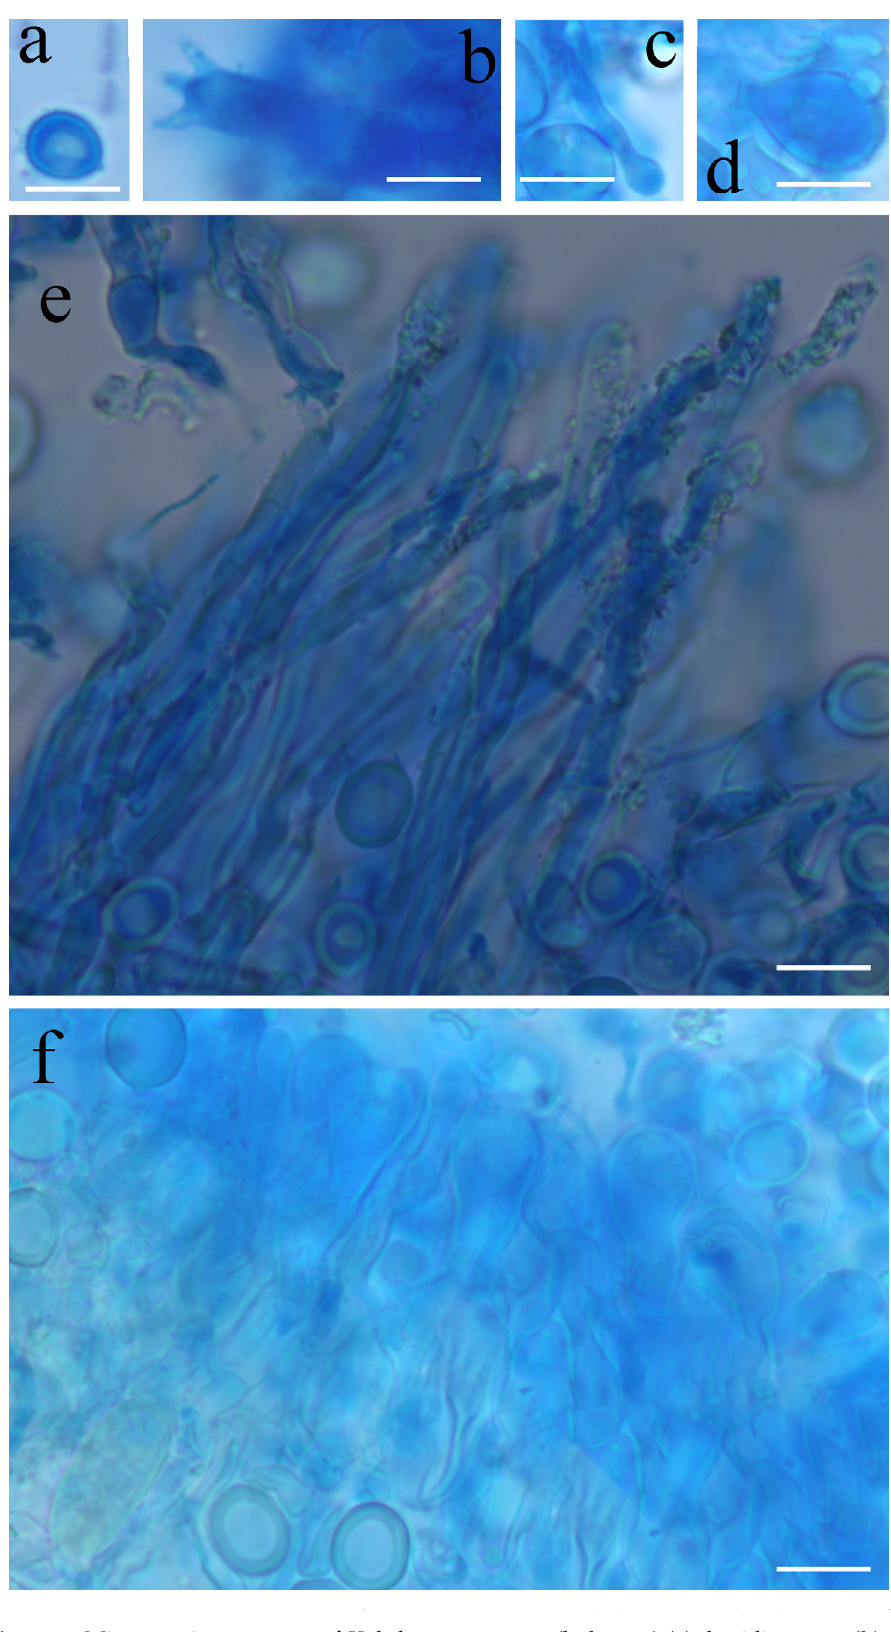
Figure 7. Microscopic structures of Xylodon macrosporus (holotype) ( a ): basidiospores ( b ), basidia ( c ), capitate cystidia ( d ), cystidia ( e ), and cylindrical cystidia ( f ). A section of hymenium. Bars: a–f = 10 µm, 10 × 100 Oil.